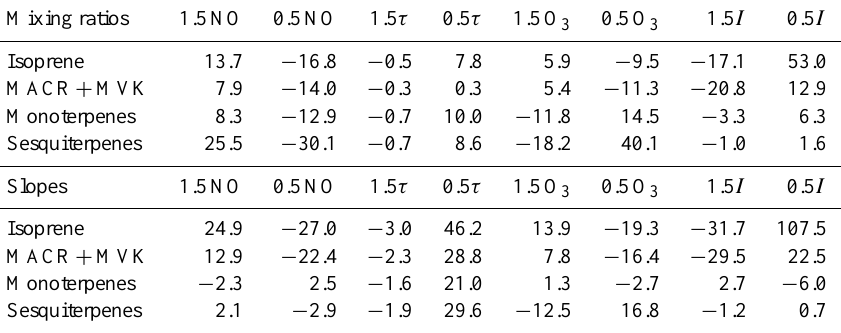
Table 4. Percentage change in average mixing ratio and slope for a 2 day model run with modified: input NO; transport lifetime ( τ ), input O 3 ; and input solar flux. Changes are relative to the “active surface” model